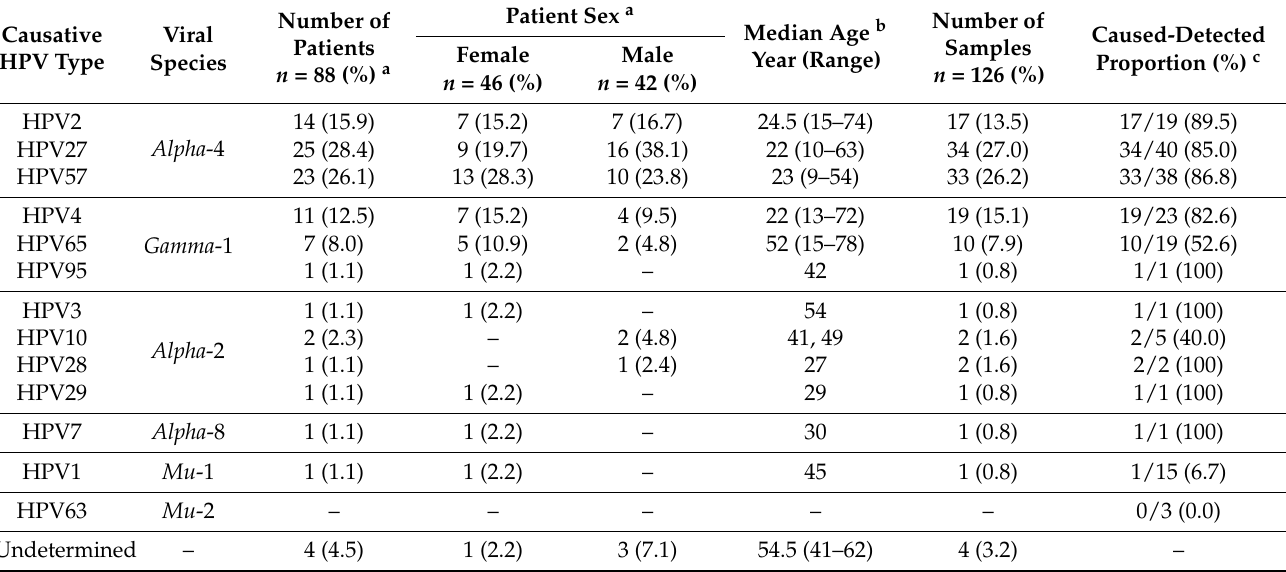
Table 3. Prevalence of 12 causative human papillomavirus (HPV) types in 126 HPV-positive histolog- ically confirmed common warts obtained from 88 immunocompetent